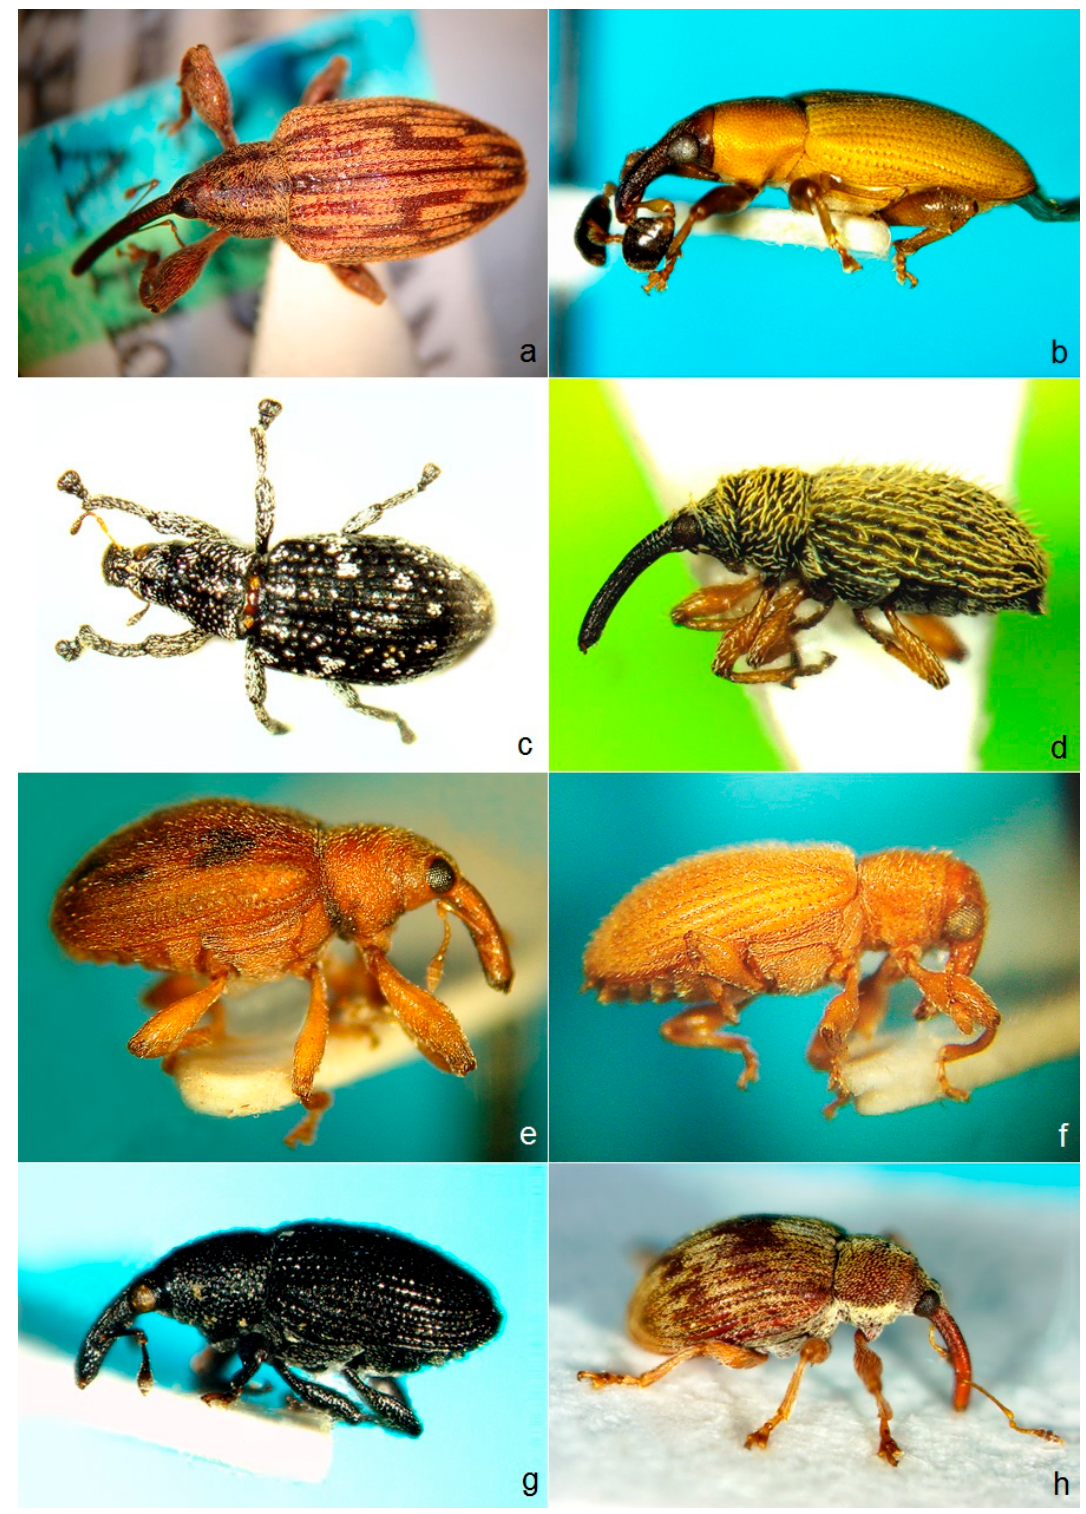
Figure 5. Curculioninae II. Ochyromerini: Opseoscapha cf. alternans Faust, 1888 ( a ); Katsurazo sp. ( b ); Viticis spec. ( c ); Lepidimerodes sp. ( d ); Endaeus sp. ( e ); a small yellowish Ochyromera species ( f ); resembling Endaeus species, but with seven funicular segments, and one unidentified and possibly new genus with seven funicular segments ( g ). The last photo ( h ) shows a member of Anthonomini ( Usingerius parvidens ) resembling Ochyromerini.